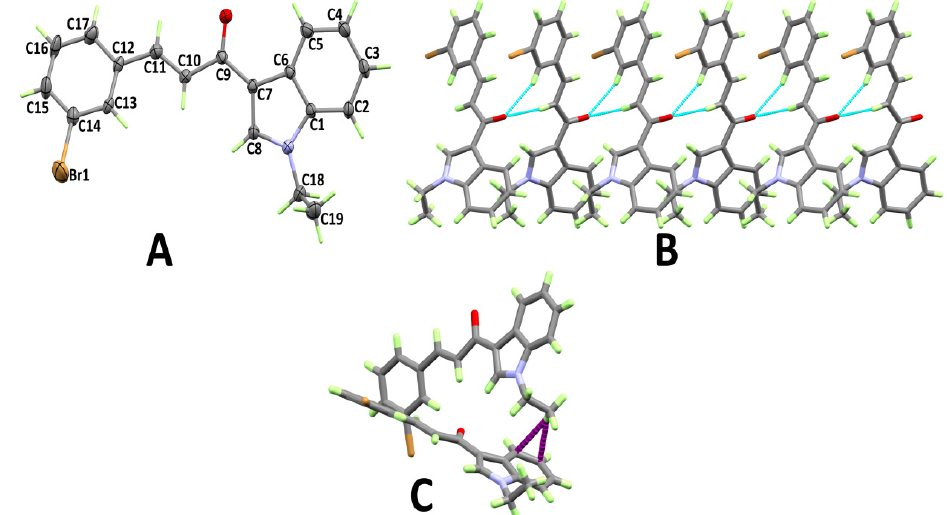
Figure 2. Atom numbering and thermal ellipsoids drawn at 30% probability level ( A ), hydrogen bonds, ( B ) and C–H ··· π interactions ( C ) in 3b .